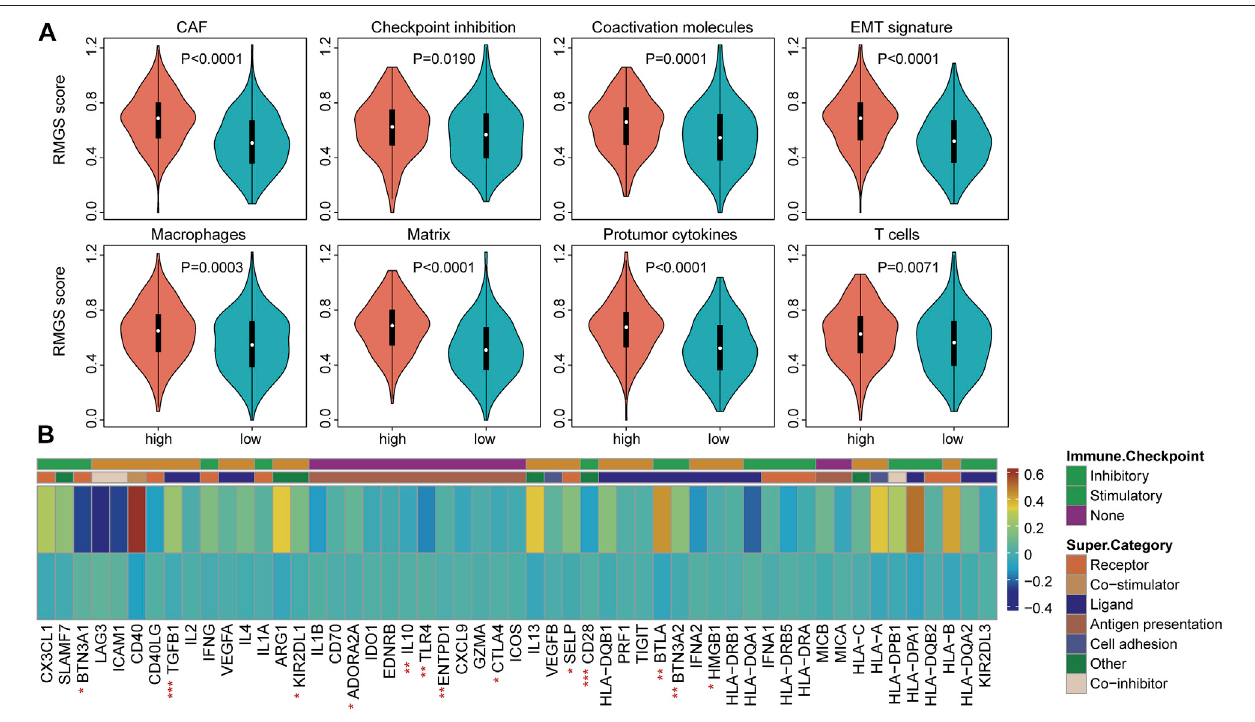
FIGURE 3| (A) Boxplotsof the RMGS score between the high- and low-risk immunetype groups (B) Comparison of the mean expression with expressions at the tumor sites relative to the high- and low-RMGS score in the immune checkpoint molecules. Statistical signi fi cance at the level of p < 0.05, pp < 0.01, and ppp < 0.001.